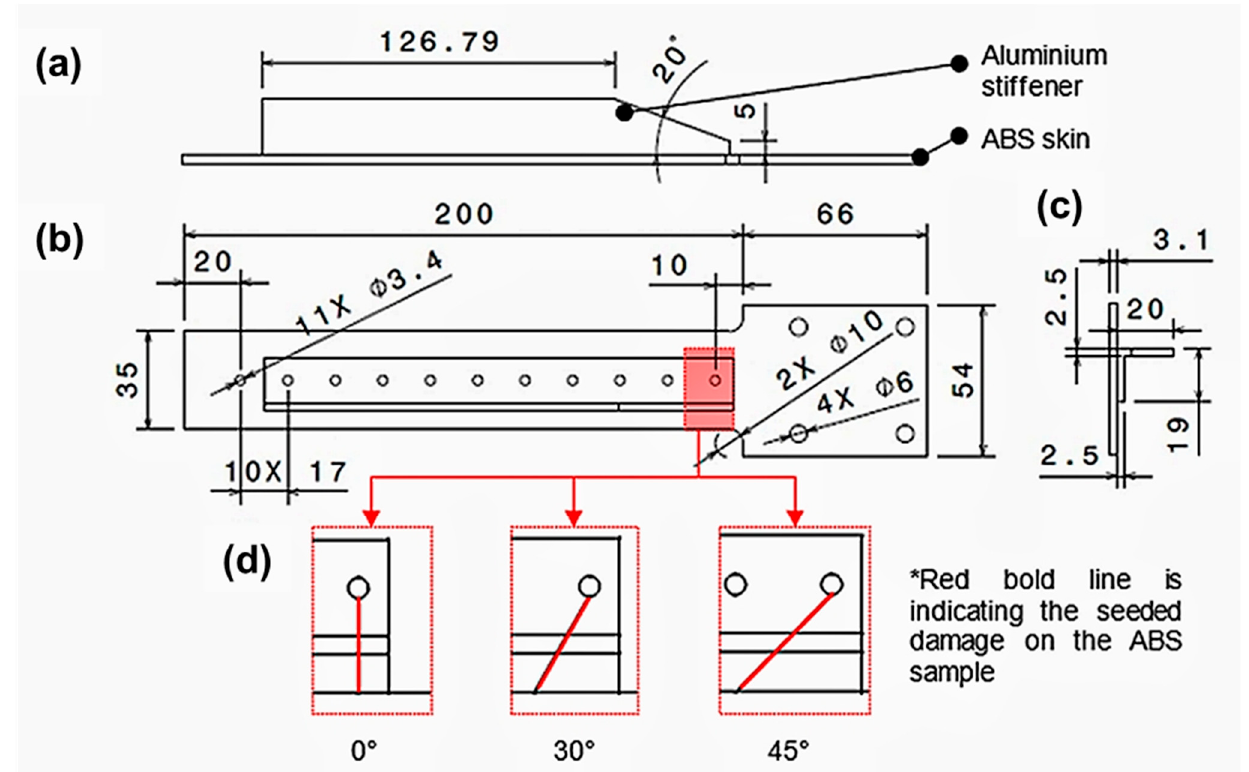
Figure 2. Specimen dimensions: ( a ) side, ( b ) top, and ( c ) cross-sectional view; ( d ) damage orientation from top view. Red line from the bolt represents the initial-seeded crack orientation.